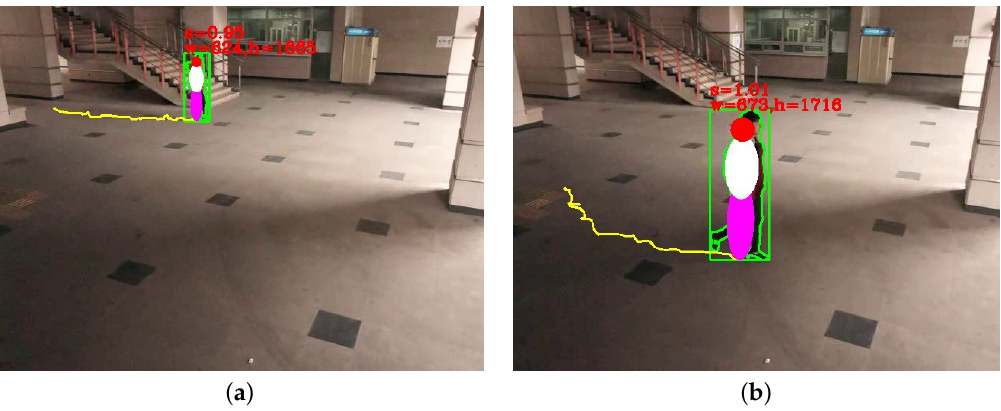
Figure 11. Size estimation results of the same object that is ( a ) far from the camera; ( b ) close to the camera.